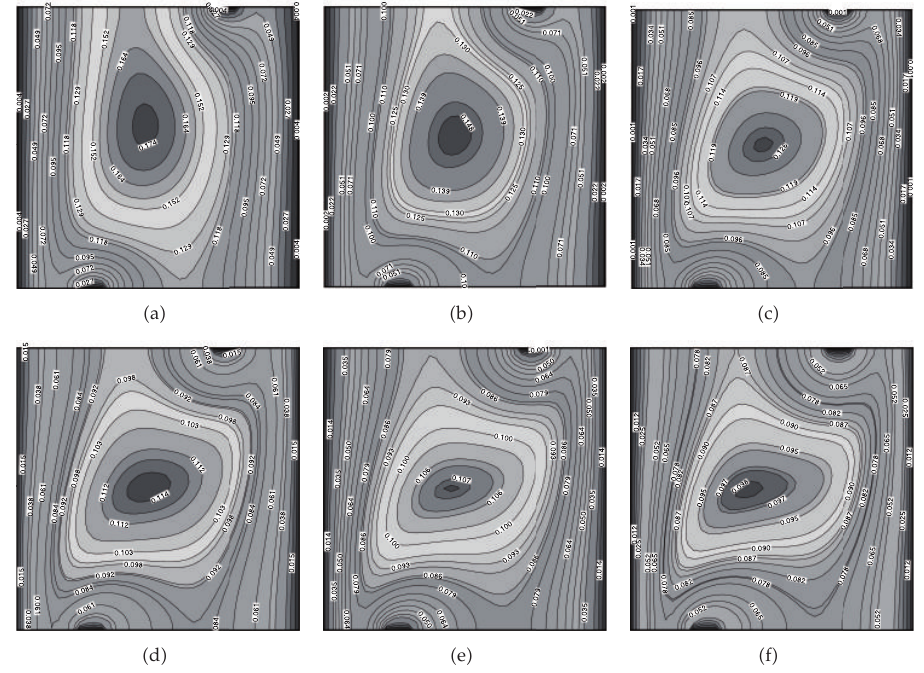
Figure 20: Streamline contours along the left vertical wall while fixing B (cid:8) 1, (cid:2) D/H (cid:3) (cid:8) 0 . 1, a (cid:8) 0 . 1, Ra (cid:8) 100, S C (cid:8) 0 . 1 for (cid:2) a (cid:3) Ra (cid:8) 10, (cid:2) b (cid:3) Ra (cid:8) 25, (cid:2) c (cid:3) Ra (cid:8) 50, (cid:2) d (cid:3) Ra (cid:8) 75, (cid:2) e (cid:3) Ra (cid:8) 100, (cid:2) f (cid:3) Ra (cid:8)